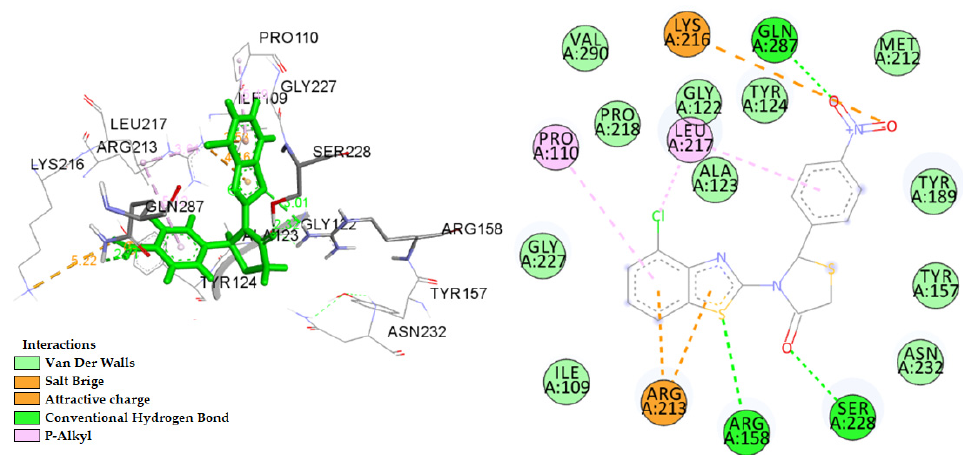
Figure 5. Docking pose of the most active compound 5 (green) in the active site of the E. coli MurB enzyme. Dotted green lines represent the hydrogen bonds.